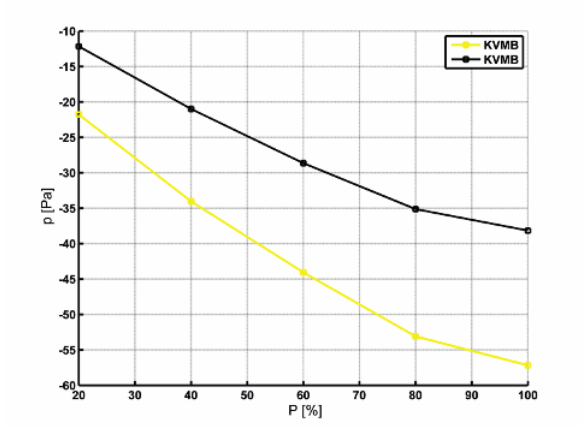
Fig. 7. Pressure variation for measurement with and without noz- zle with di ff erent fans performance P. (black - with nozzle, yellow - without